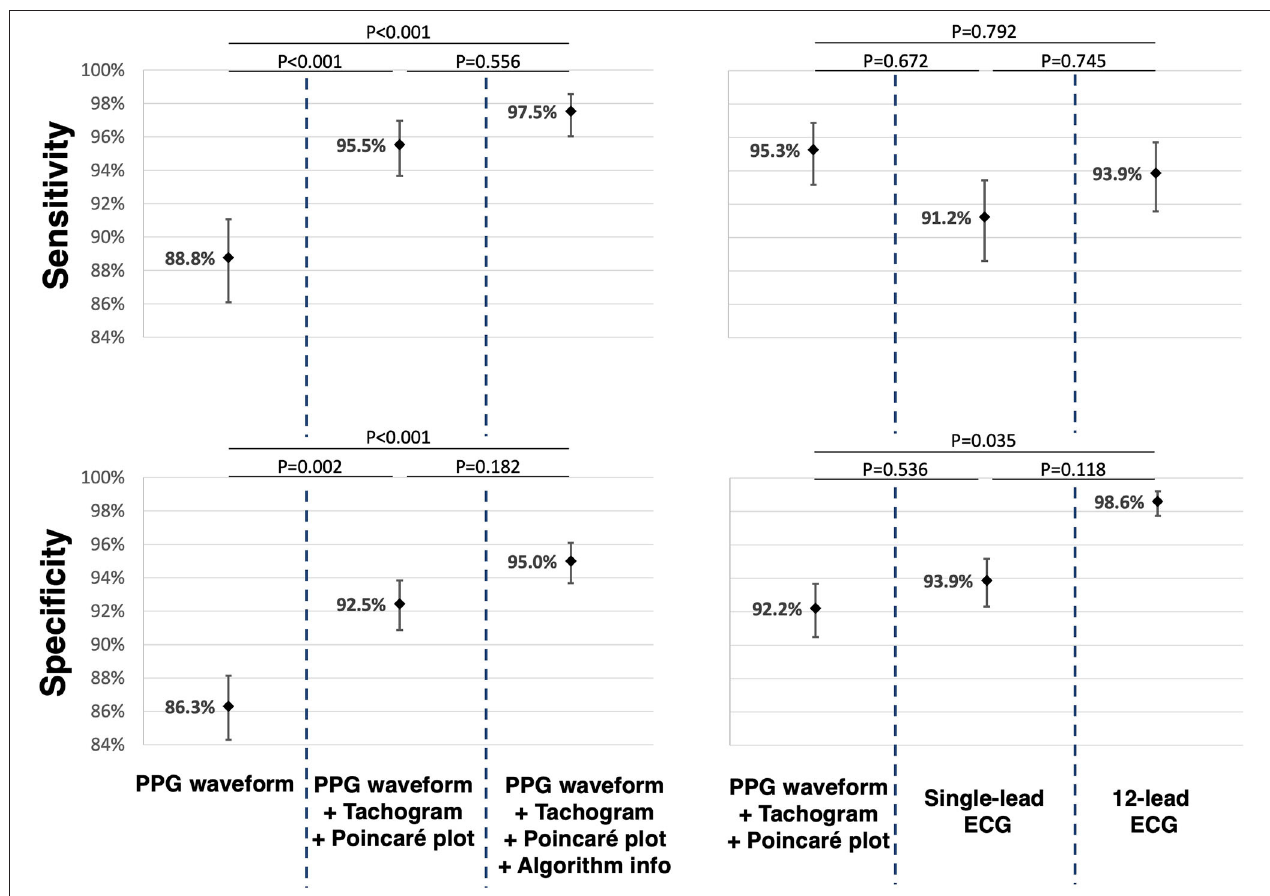
FIGURE 3 | For the comparison of the different PPG presentations reciprocally, paired data of 65 participants were used. For the comparison of PPG, single-lead and 12-lead ECG, paired data of 57 participants were used. The mean sensitivity and mean specificity are displayed as dots with corresponding confidence interval. P -values were added for reciprocal comparison. PPG, photoplethysmography; ECG,